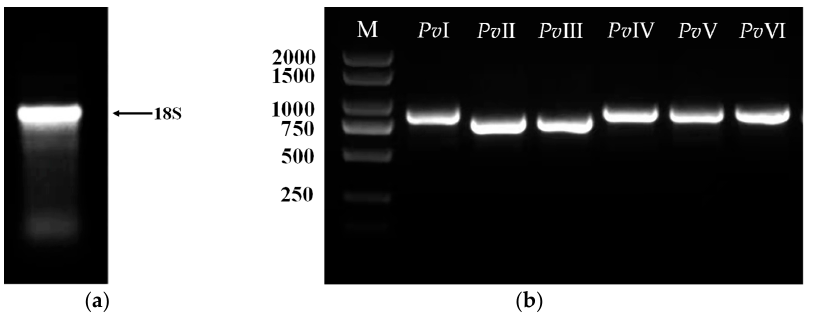
Figure 12. The S1 specificity pocket of six predicted 3D structures are shown in the colored regions.